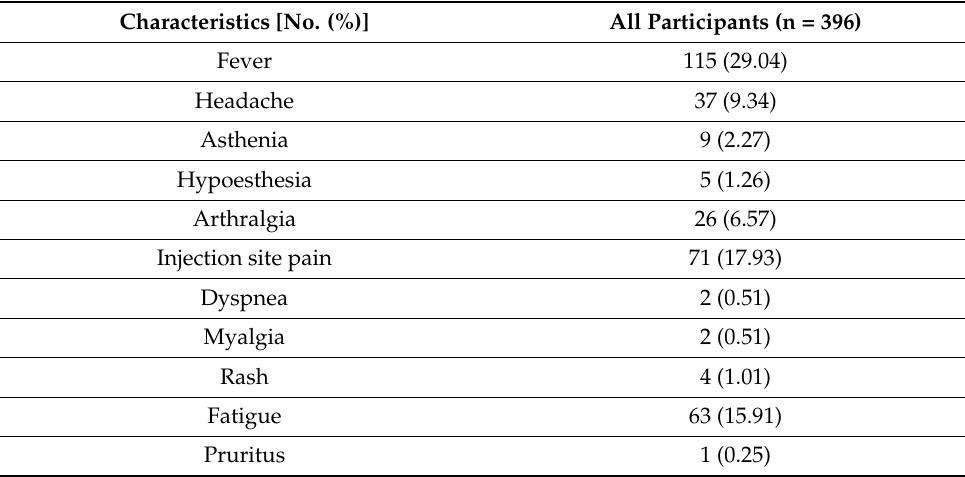
Table 2. Symptoms after receiving the first dose of the ChAdOx1 nCoV-19 vaccination. Characteristics [No. (%)]